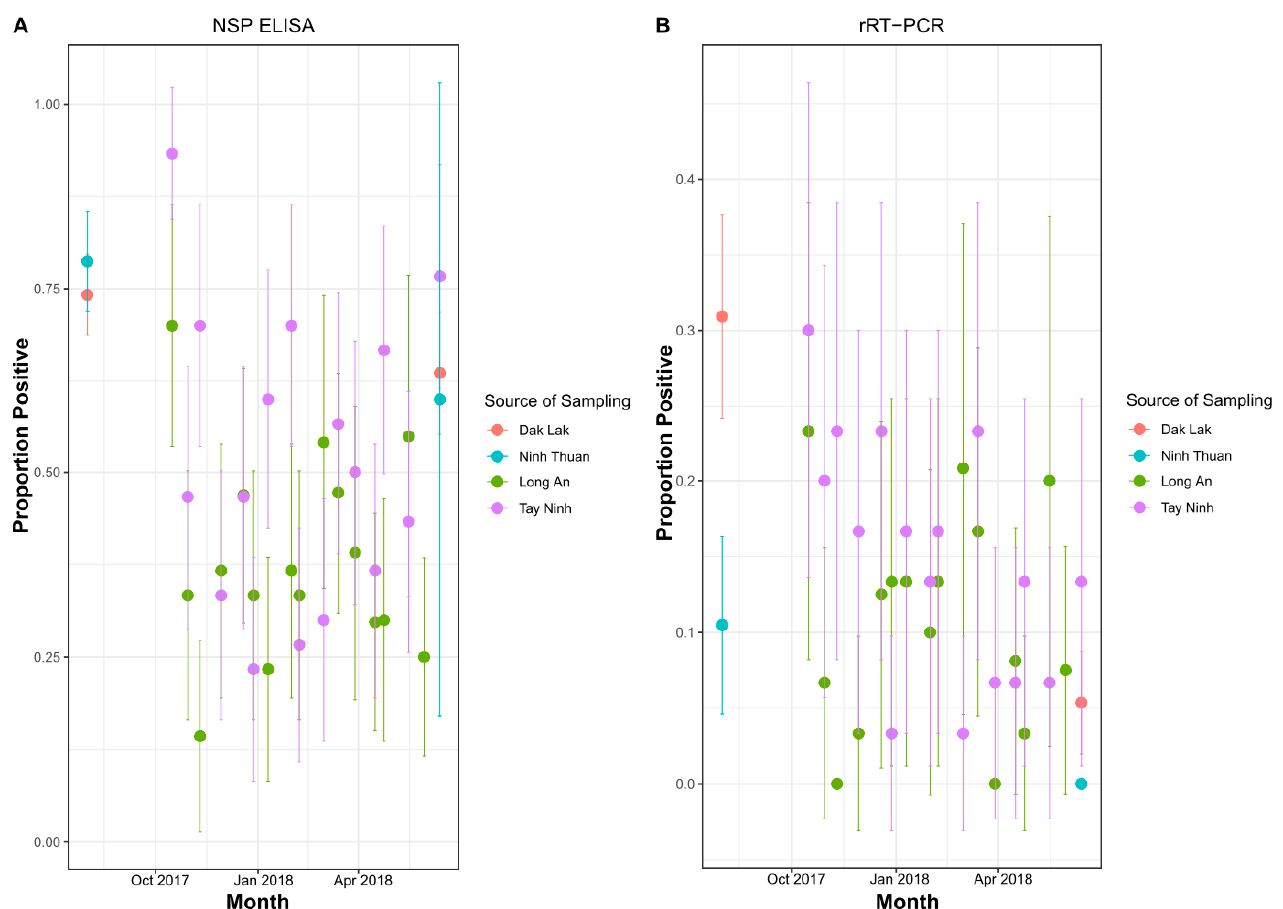
Figure 1. ( A ) Proportion of animals with antibodies against FMD NSPs in farms and slaughterhouses from August 2017 to June 2018. ( B ) rRT-PCR detection rate of FMDV RNA in oropharyngeal fluid from farms and slaughterhouses from August 2017 to June 2018. Error bars represent 95% confidence intervals. Slaughterhouses were in Long An and Tay Ninh. Farms were in Ninh Thuan and Dak Lak.